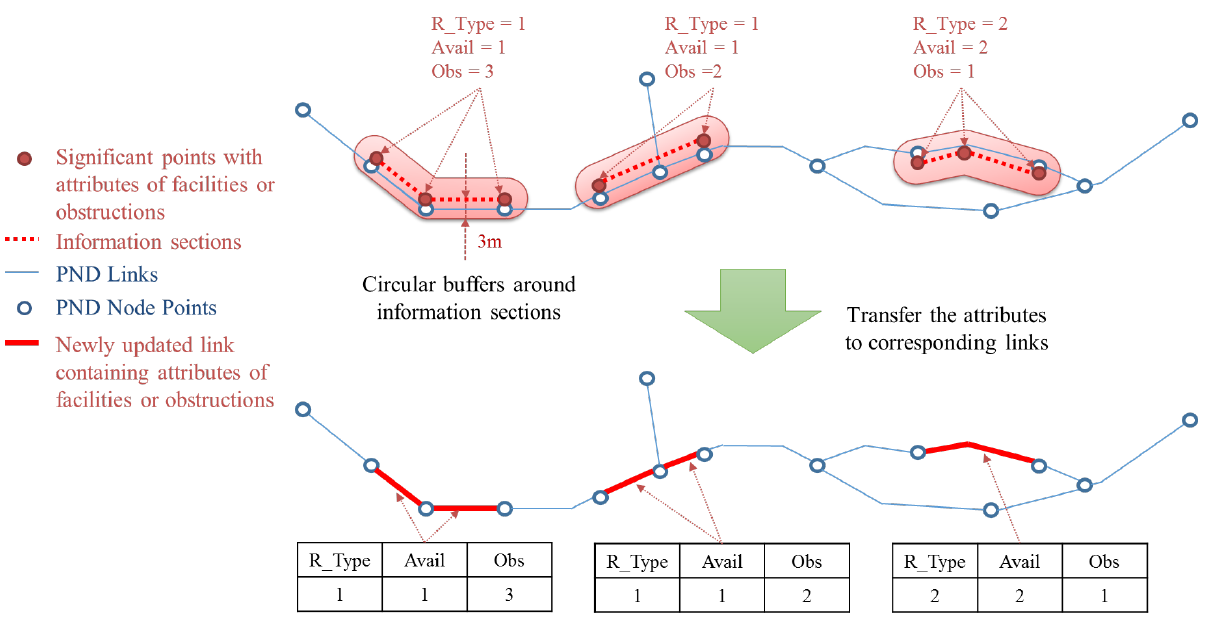
Figure 8. Process for extracting PND links of facilities or obstructions and transferring attributes from the significant points to the PND